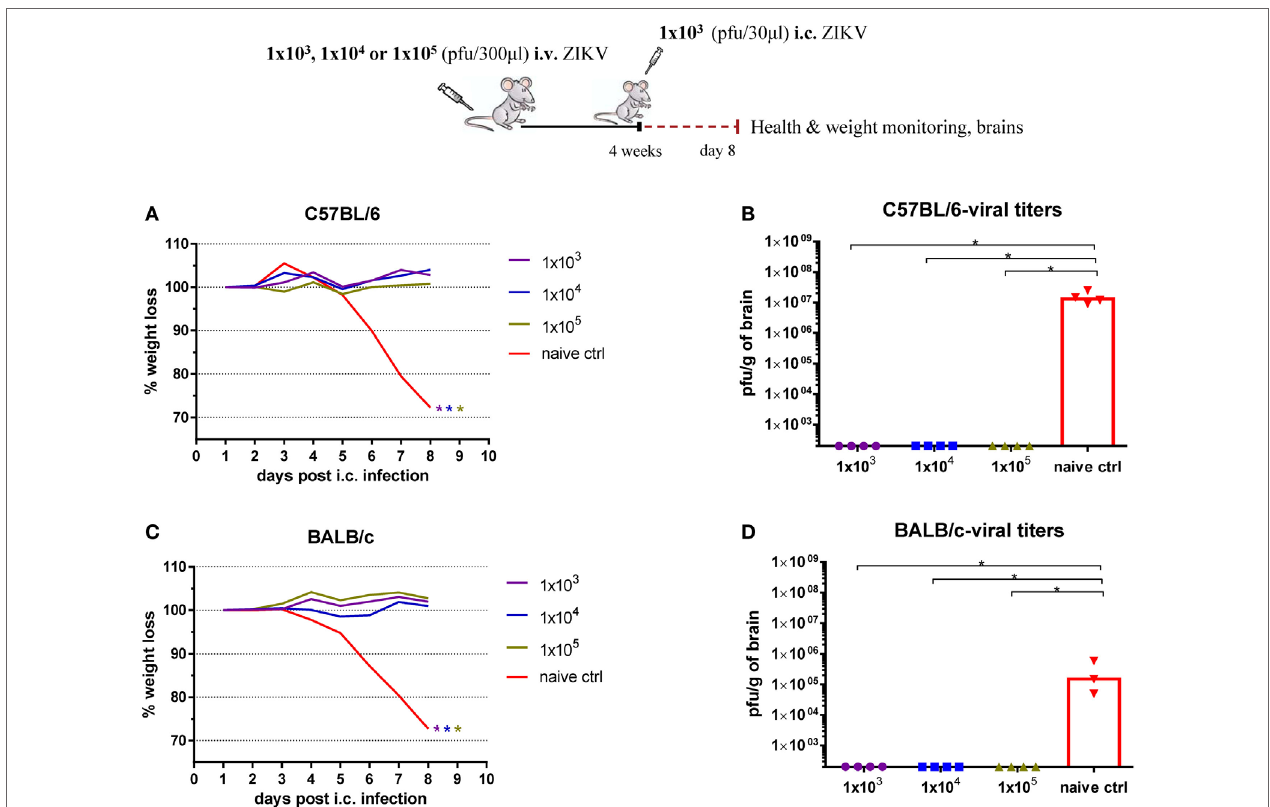
FigUre 2 | Determination of a suitable dose for i.v. immunization. Wild-type C57BL/6 (a,B) and BALB/c (c,D) mice were inoculated with 1 × 10 3 , 1 × 10 4 , or 1 × 10 5 pfu Zika virus (ZIKV) i.v., and 4 weeks later, these mice and naïve controls were challenged with 1 × 10 3 pfu ZIKV i.c. Mice were weighed daily (a,c) , and on day 7 post i.c. challenge, brains were removed and viral titers were measured by a plaque assay (B,D) . The detection limit for virus in the brain was 250 pfu/g organ. Each dot represents an individual animal and bars the medians of the groups. The weight curves (a,c) depict the group medians. n = 3–4 mice/group, * p < 0.05. For the weight curves, the color of the star denotes the infected group, which forms the basis for statistical comparison with naïve mice.